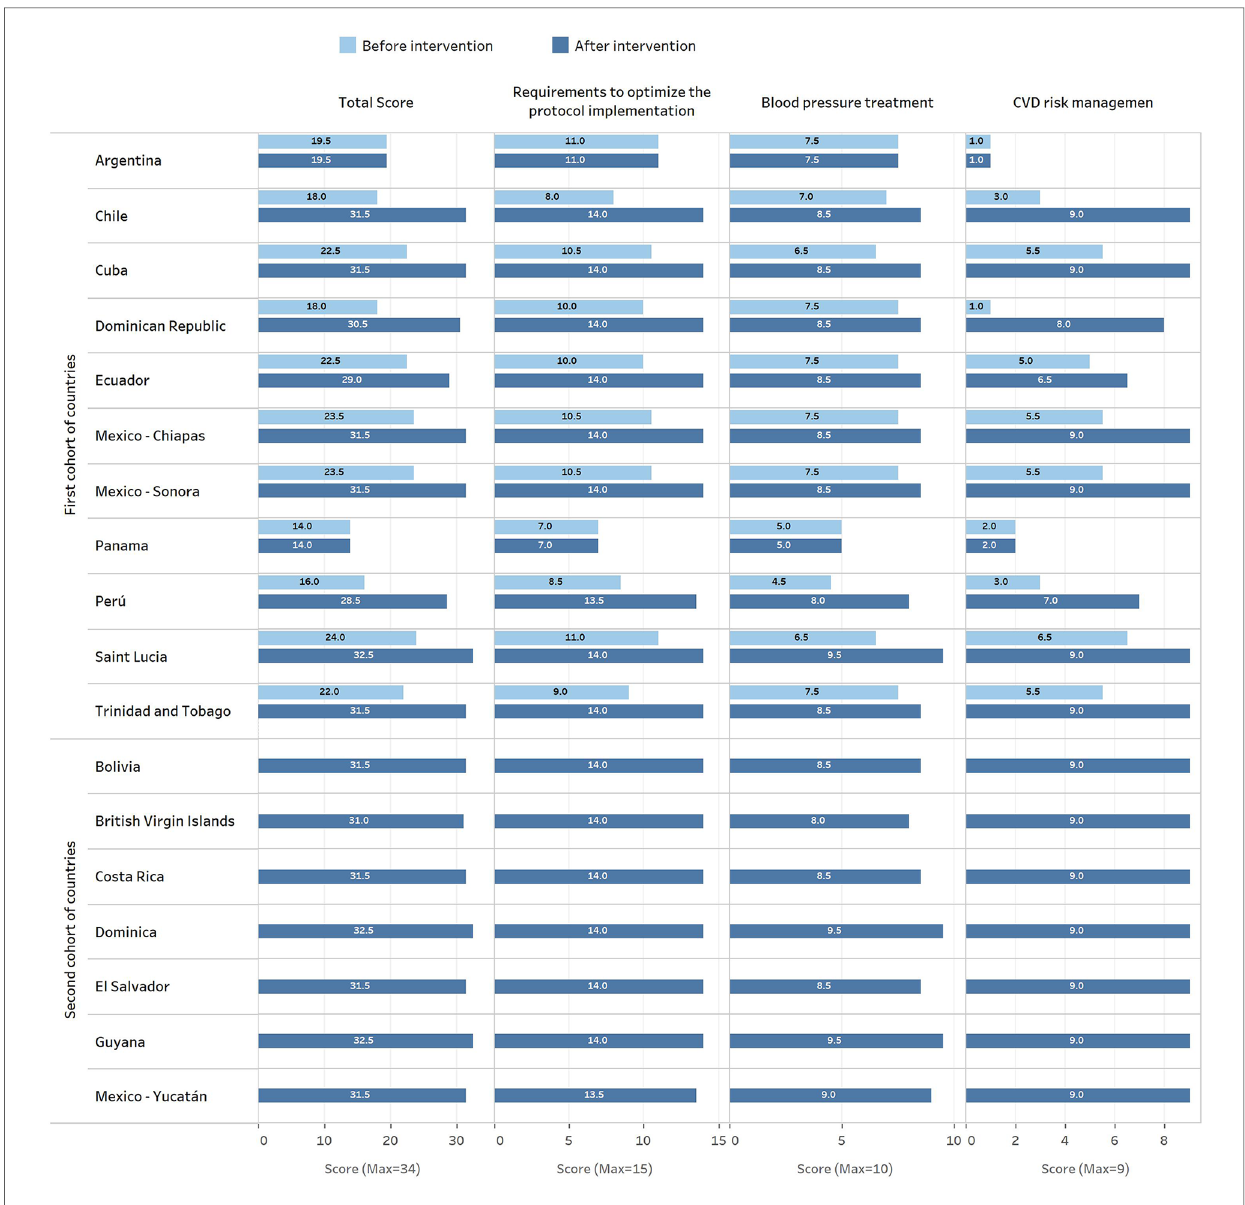
FIGURE 4 HEARTS appraisal check list scores before and after the evaluation and improvement process by